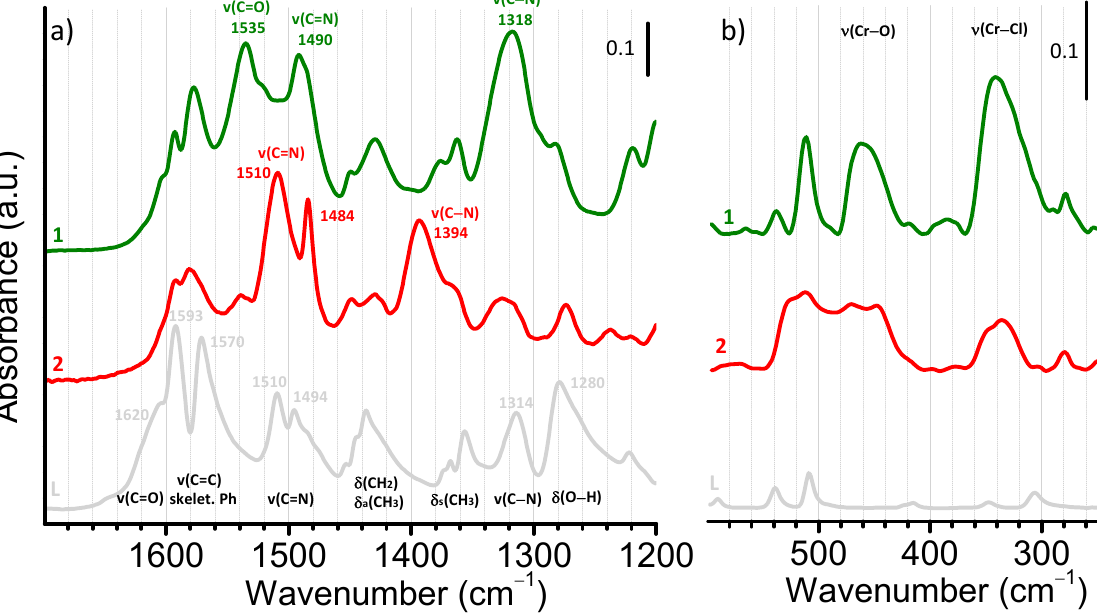
Figure 2. ATR ‐ IR ( a ) and Far ‐ IR ( b ) spectra of complexes 1 (green line) and 2 (red line) in comparison to that of the ligand L (grey line)in the most relevant spectroscopic regions. Measurements were performed on complexes in the solid state.